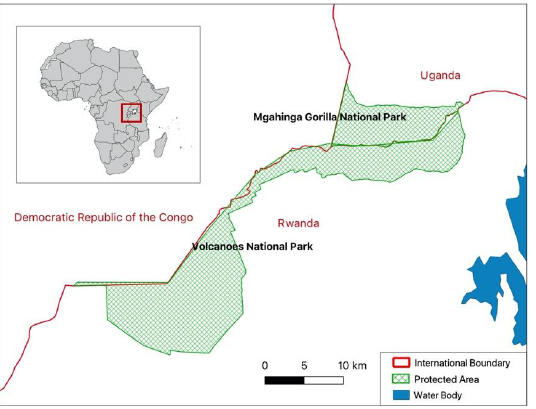
Figure 1. Map of Virunga Landscape (VL). Credit: Katie Bernhard